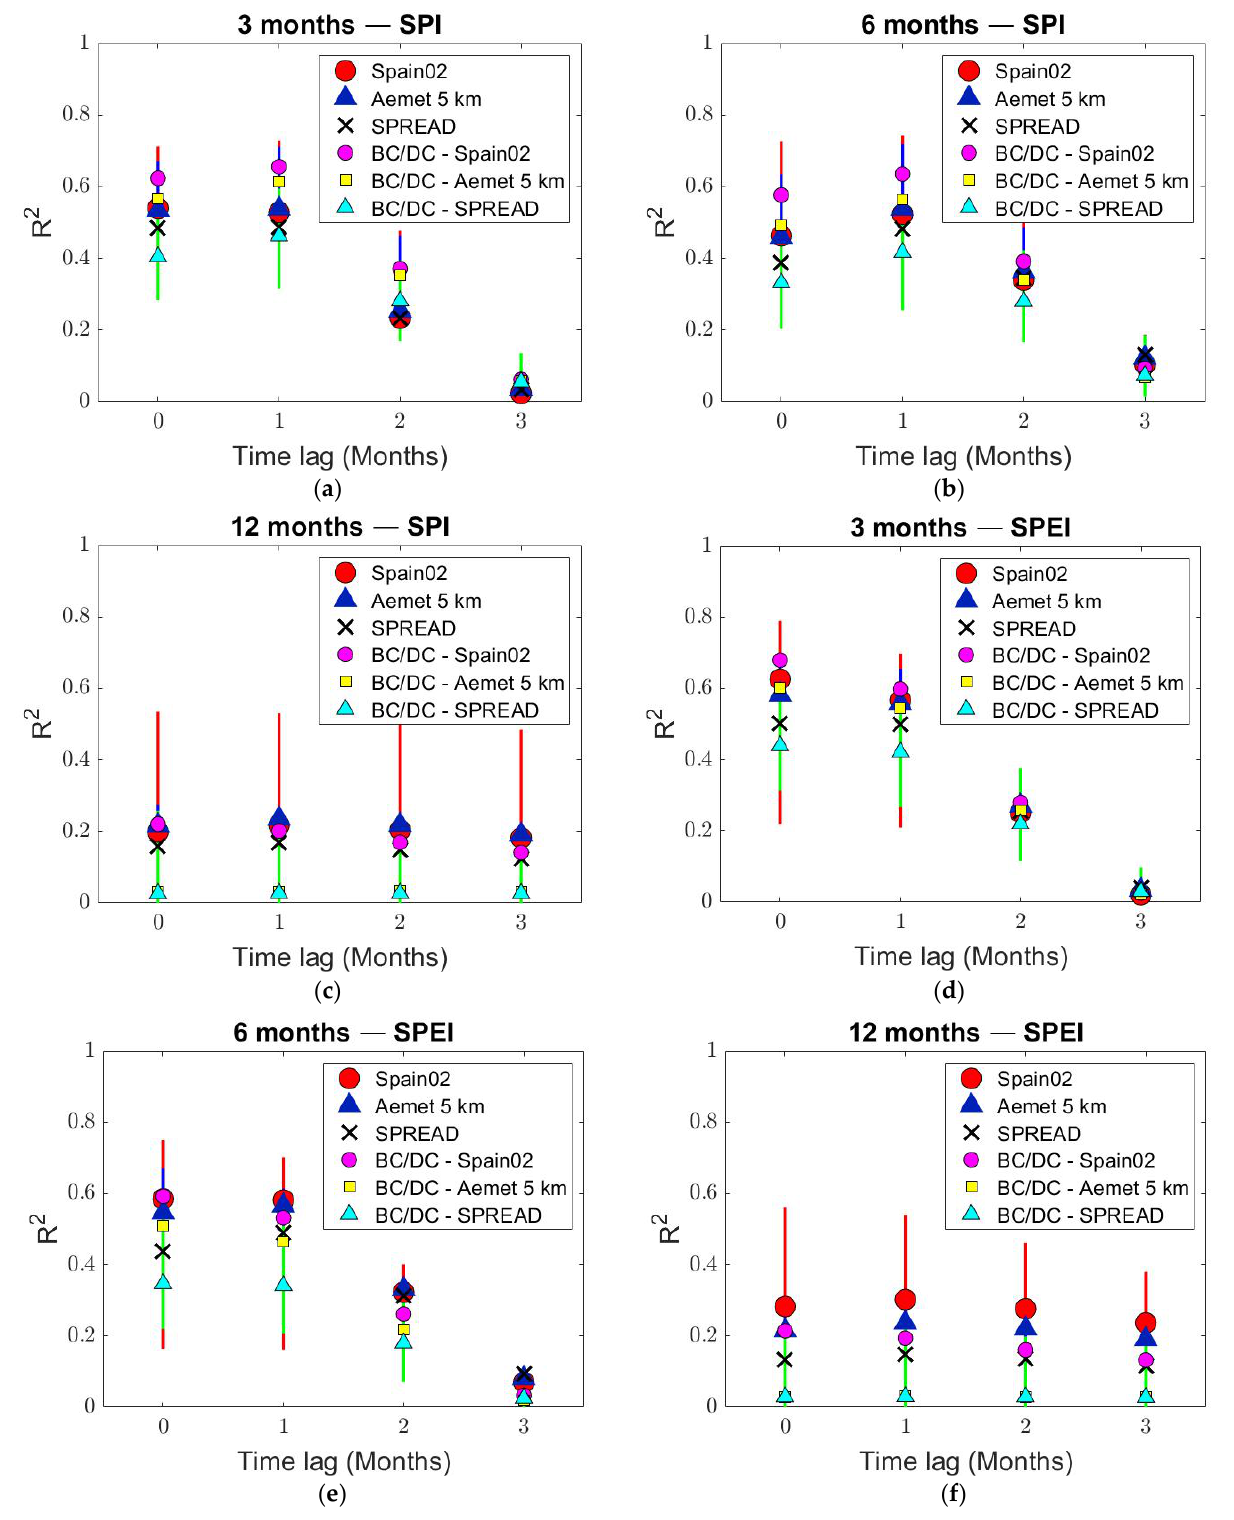
Figure 12. Correlation between meteorological (SPI) and hydrological (SSCI) drought for the ( a ) 3 months temporal-aggregation scale; ( b ) 6 months temporal-aggregation scale; ( c ) 12 months temporal-aggregation scale. Correlation between meteorological (SPEI) and hydrological (SSCI) drought for the ( d ) 3 months temporal-aggregation scale; ( e ) 6 months temporal-aggregation scale; ( f ) 12 months temporal-aggregation scale.